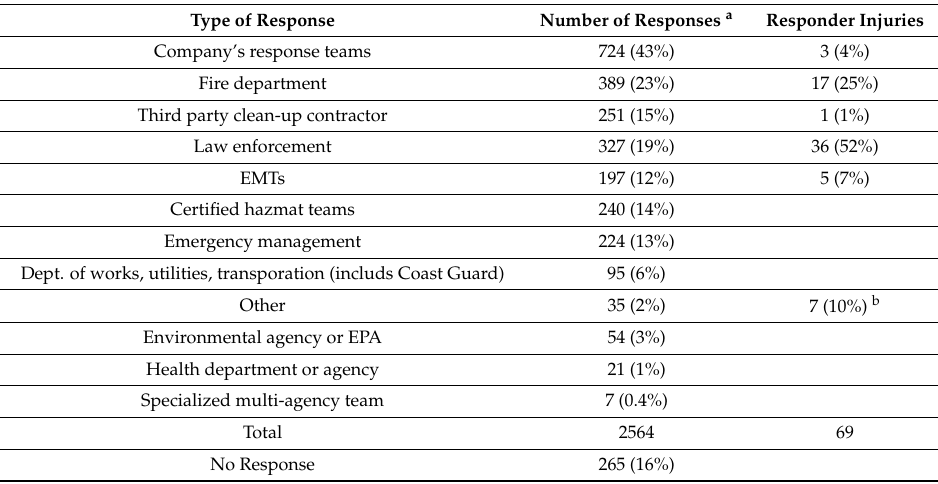
Table 4. Responses to chemical releases, North Carolina,